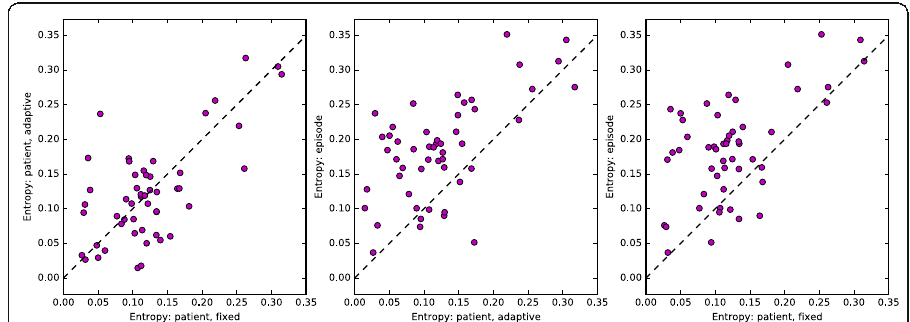
Fig. 3 Mean entropy for each HRR, computed over six 1-year windows, using each of the three different ways to construct the network: fixed-threshold, adaptive-threshold, and episode-based. Each panel shows a scatter plot of two of the three entropy measures plotted against one another: fixed-threshold vs. adaptive- threshold (left), adaptive-threshold vs. episode-based (middle), and fixed-patient vs. episode-based (right). The Pearson correlation coefficients and their p-values for testing the hypothesis of no correlation are 0.66 ( p =1.159e-07), 0.61 ( p =1.804e-06), and 0.58 ( p =6.925e-06),